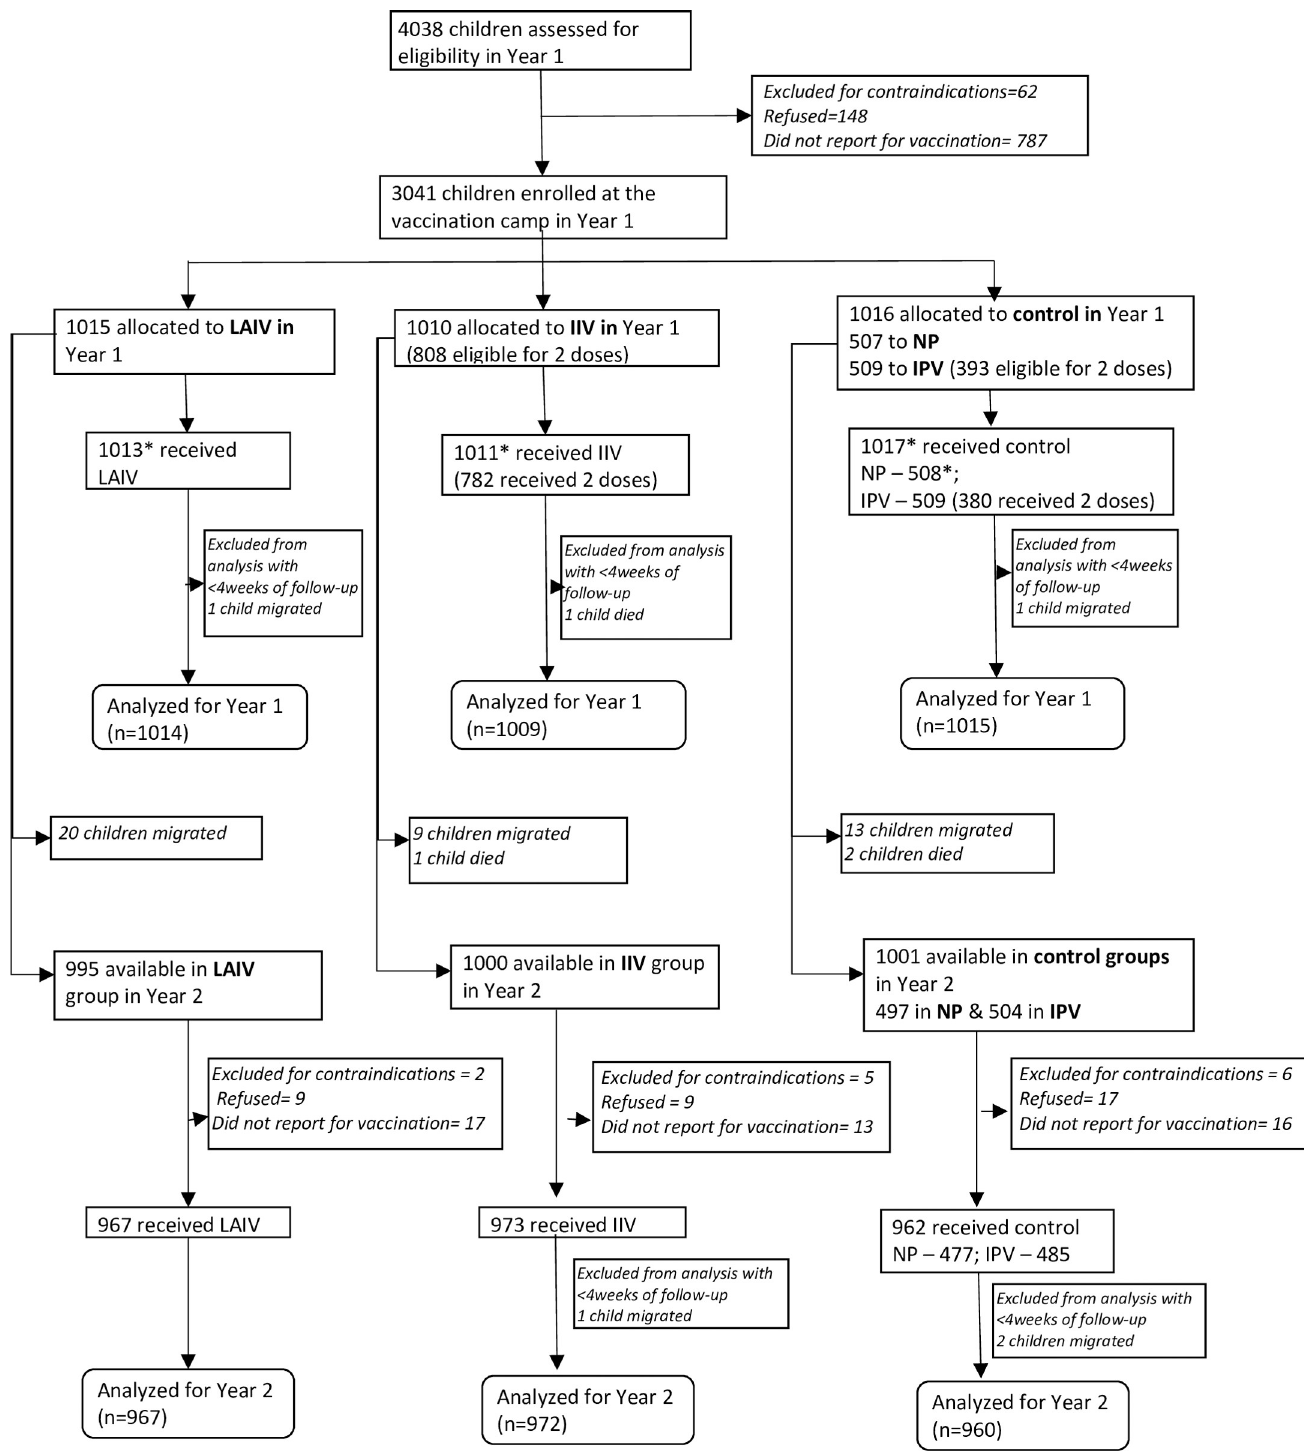
Fig 1. Flowchart of enrollment and follow-up in the trial. � Note: One child allocated to LAIV received IPV and one child received NP. IIV, inactivated influenza vaccine; IPV, inactivated polio vaccine; LAIV, live attenuated influenza vaccine; NP, nasal placebo.